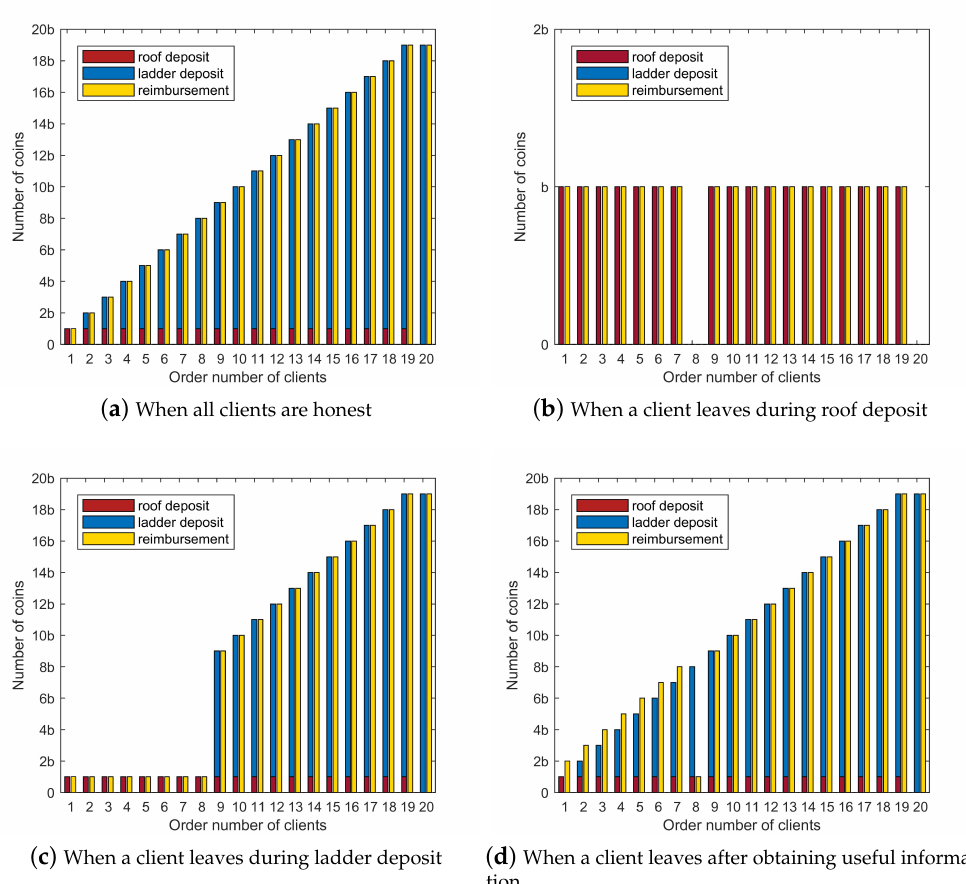
Figure 11. The circulation of digital currencies when there are 20 clients participating in FL.